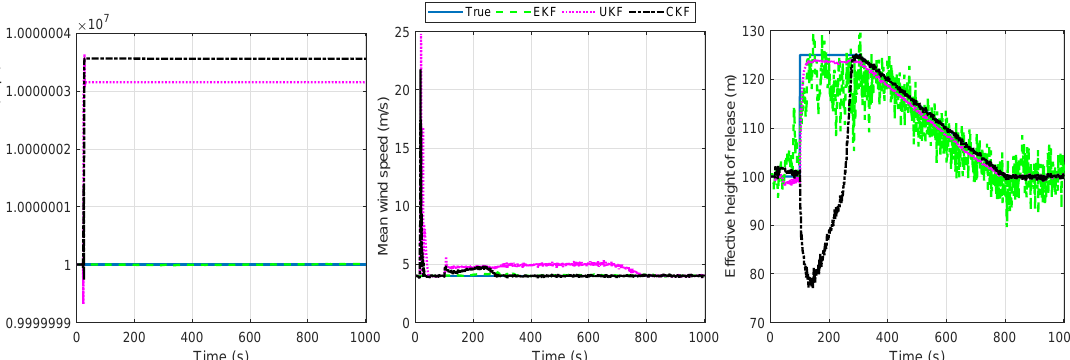
Figure 6. True, measured, and estimated dose rates at detectors D1 to D8 for variation in release height.